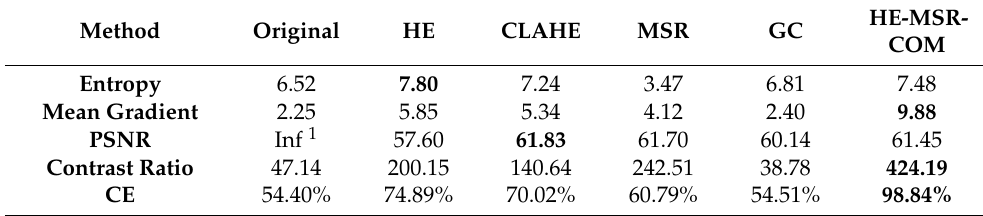
Table 3. Mean performance comparison in GTA5.